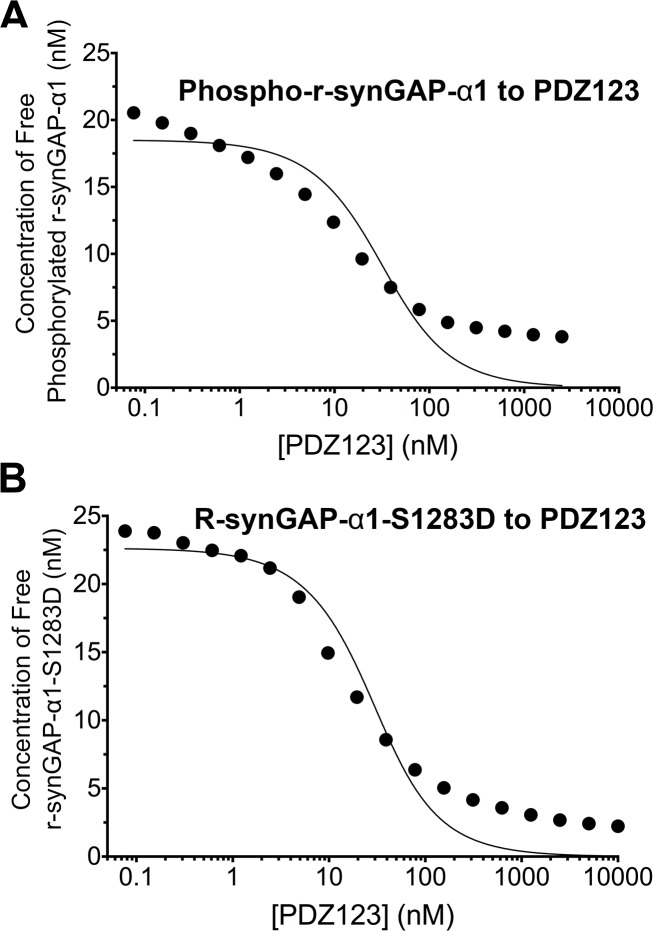
Apparent affinities of phosphorylated r-synGAP-α1 and r-synGAP-α1-S1283D for PDZ123 determined by the 'competition in solution' method.Representative plots of the concentrations of (A) free phospho-r-synGAP-α1 phosphorylated as described for PDZ Binding Assays under 'Materials and methods,' and (B) r-synGAP-α1-S1283D, measured in sample mixtures containing PDZ123 as described in Figure 4A and B, and under 'Materials and methods.' The values (black dots) were plotted against the log of the PDZ123 concentration in the mixture and fit to a binding curve as described in Figure 4C. The calculated values of KDapp are listed in Table 1.